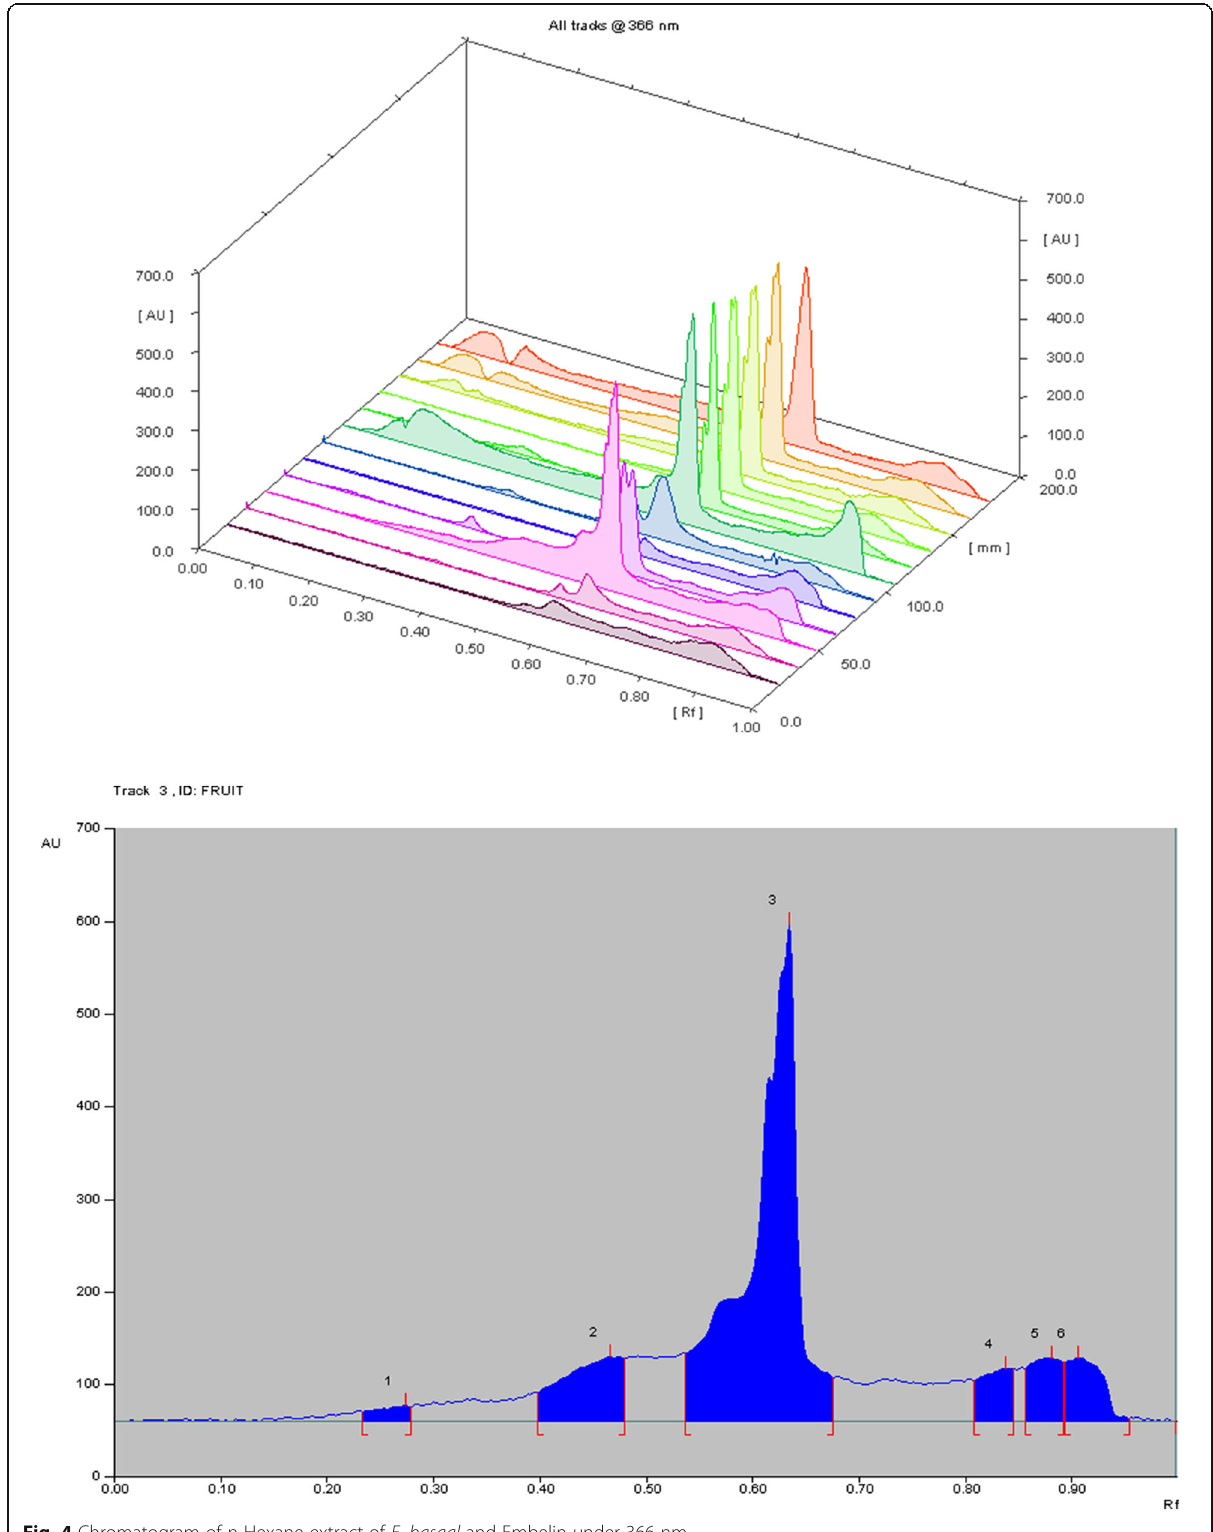
Fig. 4 Chromatogram of n-Hexane extract of E. basaal and Embelin under 366